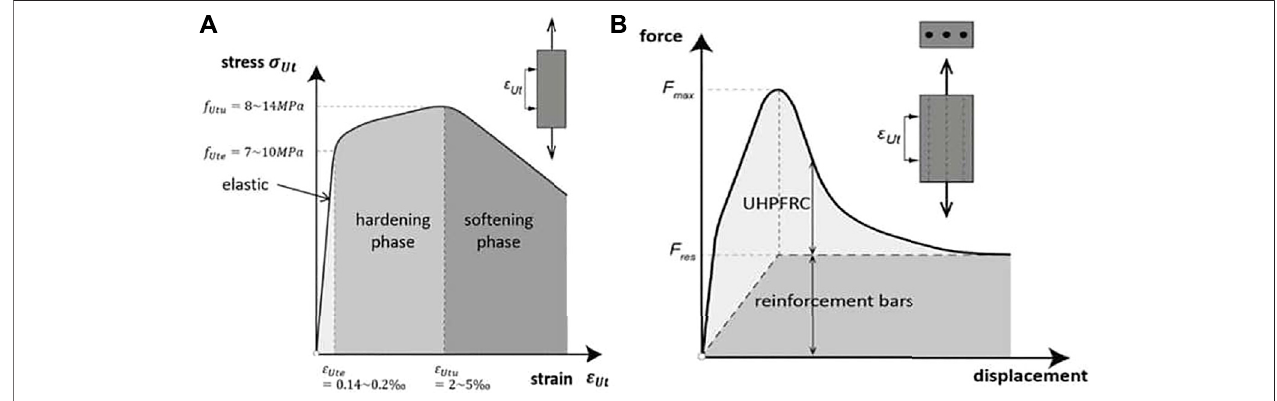
FIGURE 2 | Characteristic tensile behavior of (A) plain UHPFRC and (B) Reinforced-UHPFRC. Adapted from (Brühwiler, 2020).